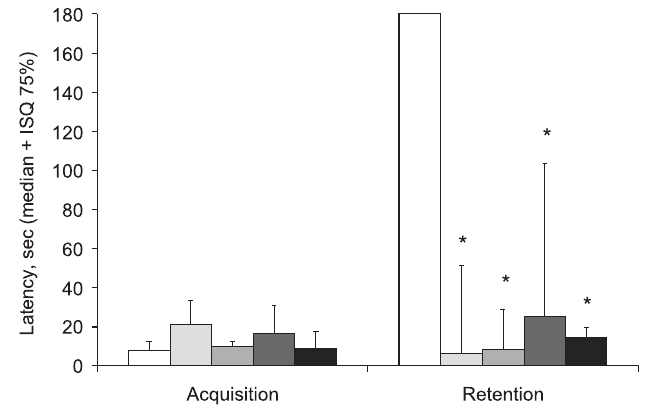
) of two lots of BST0298 extract 1/2